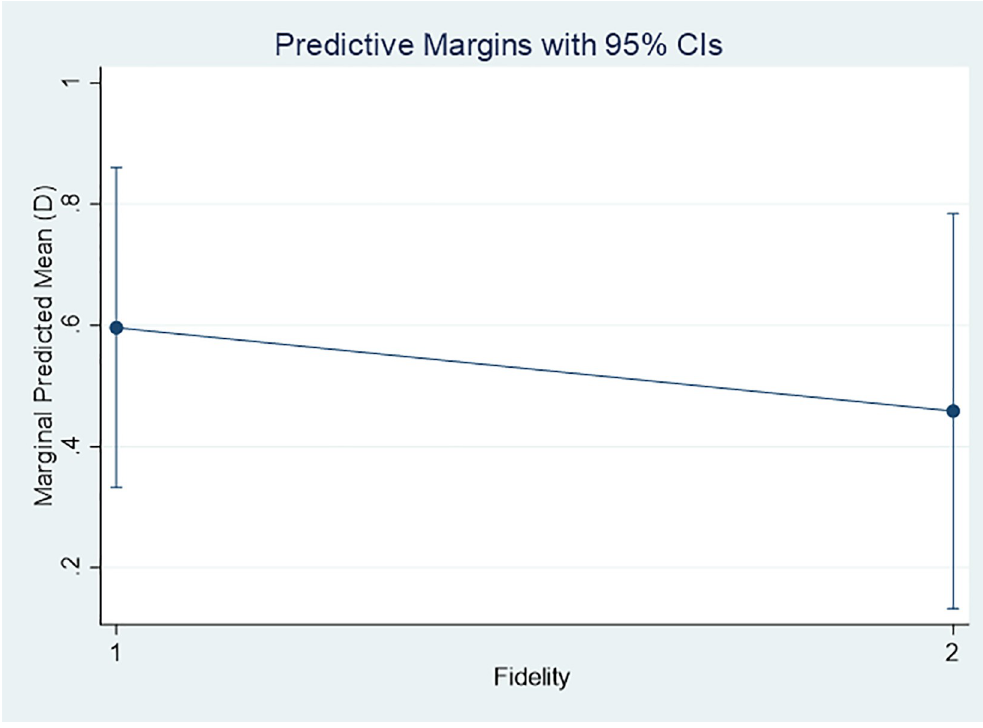
Fig 2. Margin plot demonstrating relationship between fidelity and mean decay scores.